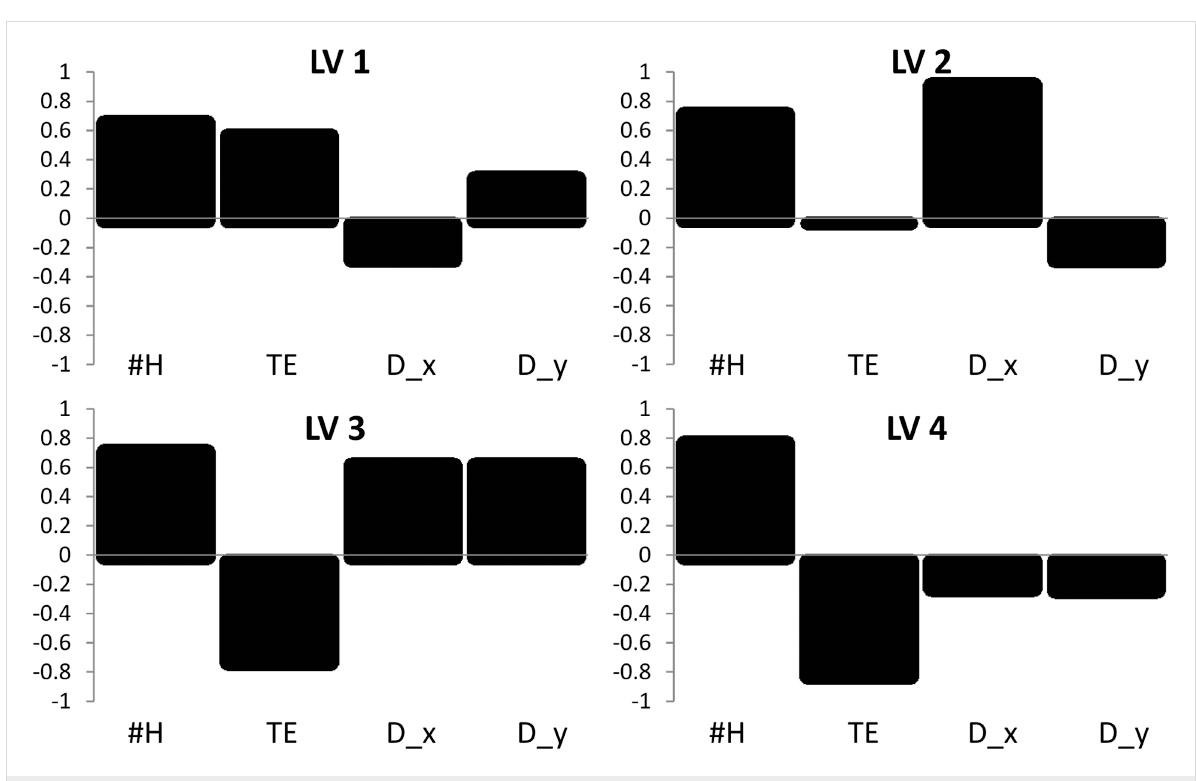
Figure 2: Significance and loading values of individual latent vectors (LVs).